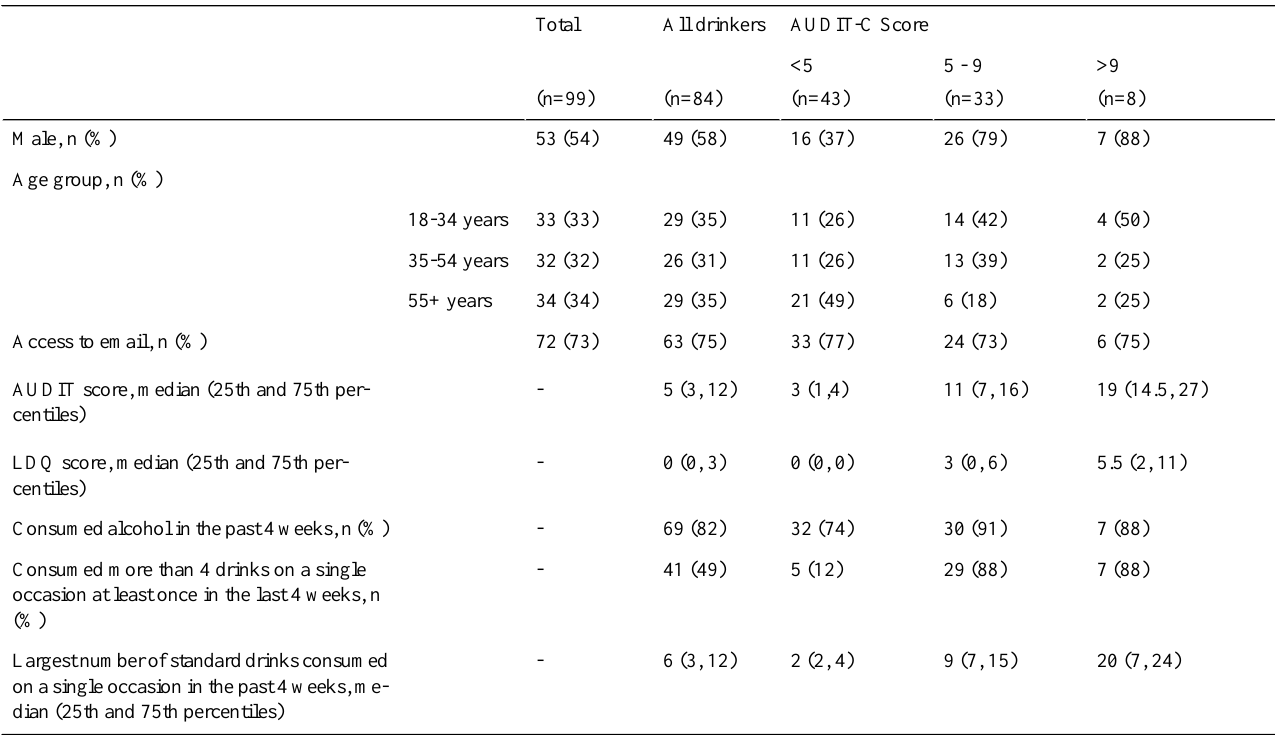
Table 1. Demographic characteristics and alcohol use of participants.